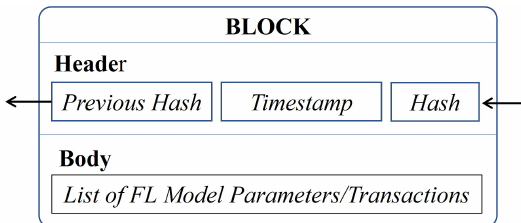
Figure 3. The data structure details of the